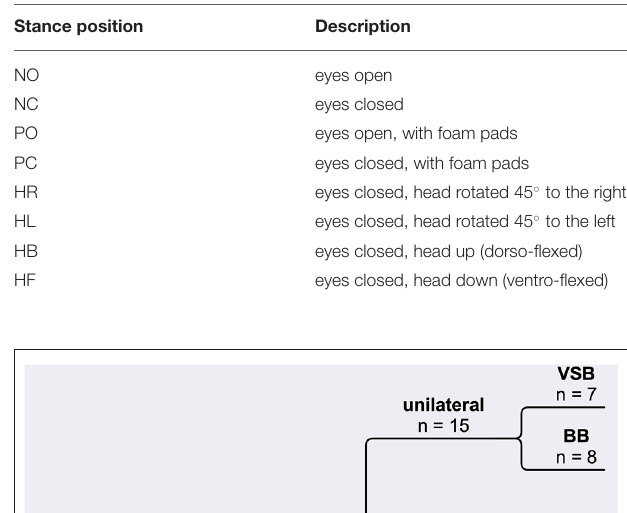
TABLE 2 | IBS task description.